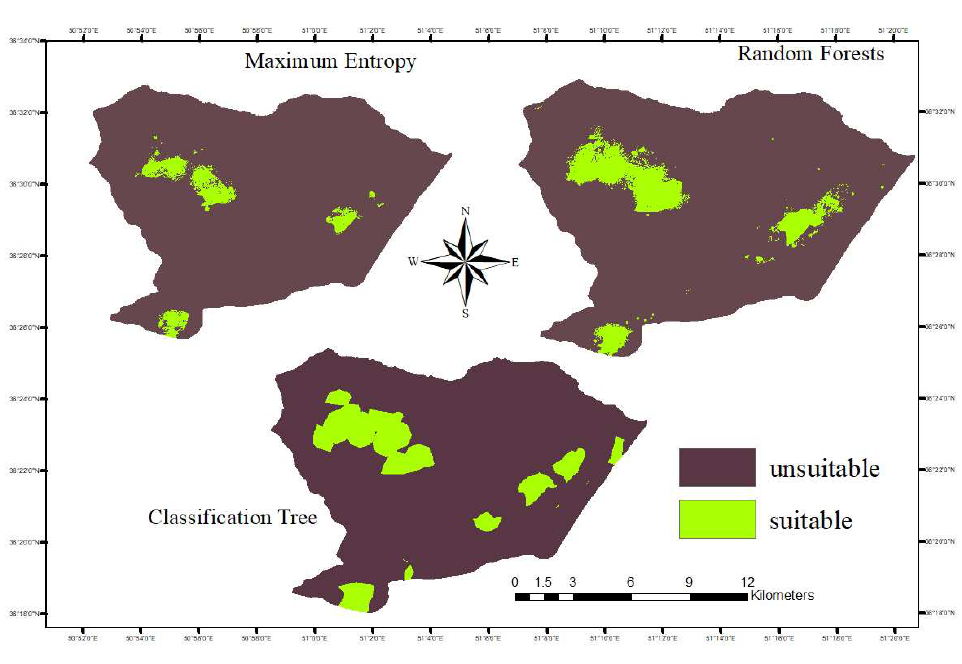
F IGURE 4. Binary maps of suitable area resulted by each model in warm